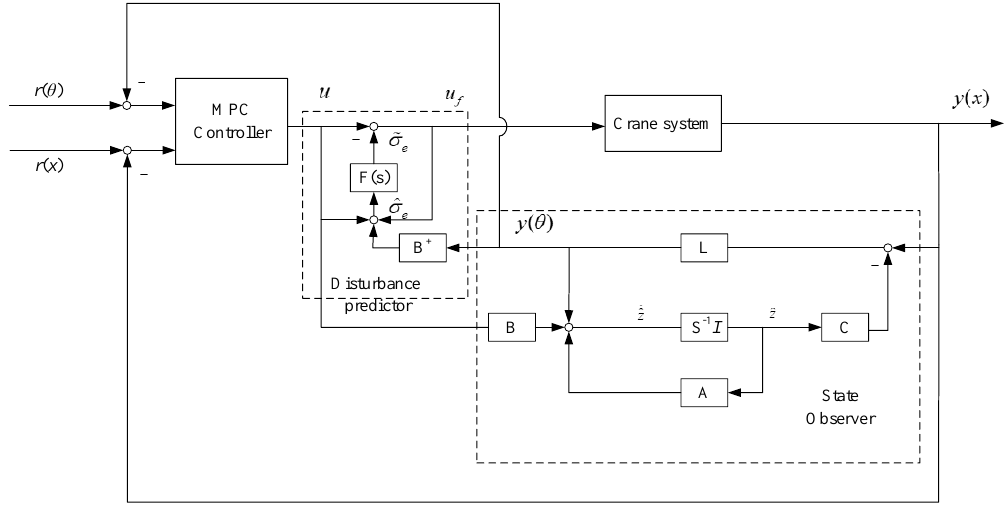
Figure 4. The simulation structure of the proposed anti-swing closed-loop control system.